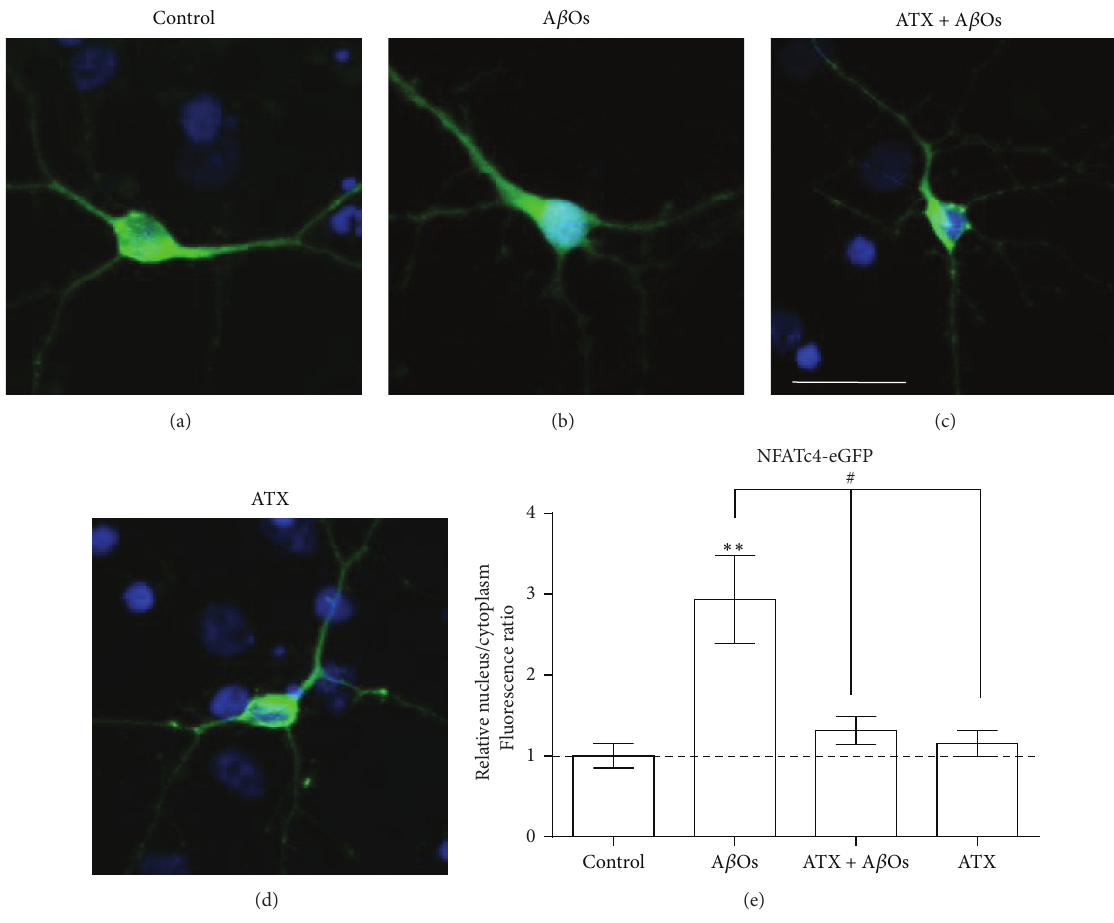
Figure 3: ATX prevents A 𝛽 Os-induced NFATc4 activation. Hippocampal neurons (13–15DIV) were transfected with EGFP-NFATc4 24 h before the experiments. ((a)–(d)) show representative images of intracellular distribution of EGFP-NFATc4 (green fluorescence) and of nuclear staining with Hoechst (blue fluorescence) in hippocampal neurons. (a) Neurons treated with vehicle, (b) stimulated with 500 nM A 𝛽 Os for 6 h, (c) preincubated with 0.1 𝜇 M ATX for 1.5h before A 𝛽 Os addition, or (d) incubated with ATX for 7.5h. Scale bar: 10 𝜇 m. (e) shows the quantification of four different experiments ( 𝑛 = 4 ) in cultures from four different animals; each condition was tested in duplicate (in total, 15–25 cells were analyzed per condition). The results are expressed as the mean ratio of nuclear/cytoplasmic fluorescence intensity ± SE, relative to control cells. Statistically significant differences among experimental conditions were evaluated by one-way ANOVA followed by Bonferroni’s multiple comparison test ( ∗∗ 𝑝 < 0.001 compared to control; # 𝑝 < 0.05 compared to indicated